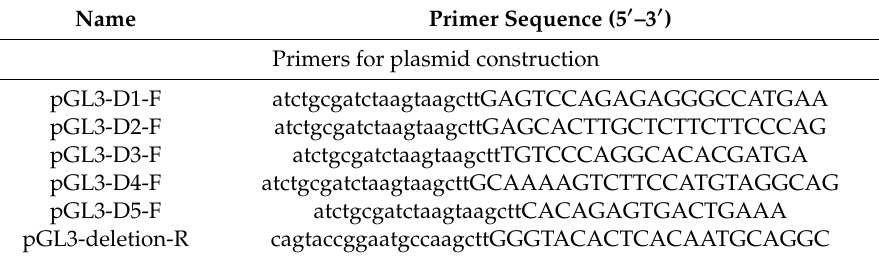
Table 1. Primers used in gene cloning and